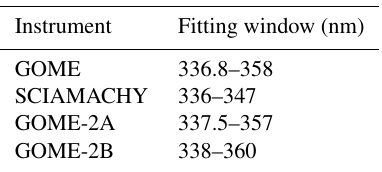
Table 3. Fitting windows used for the different